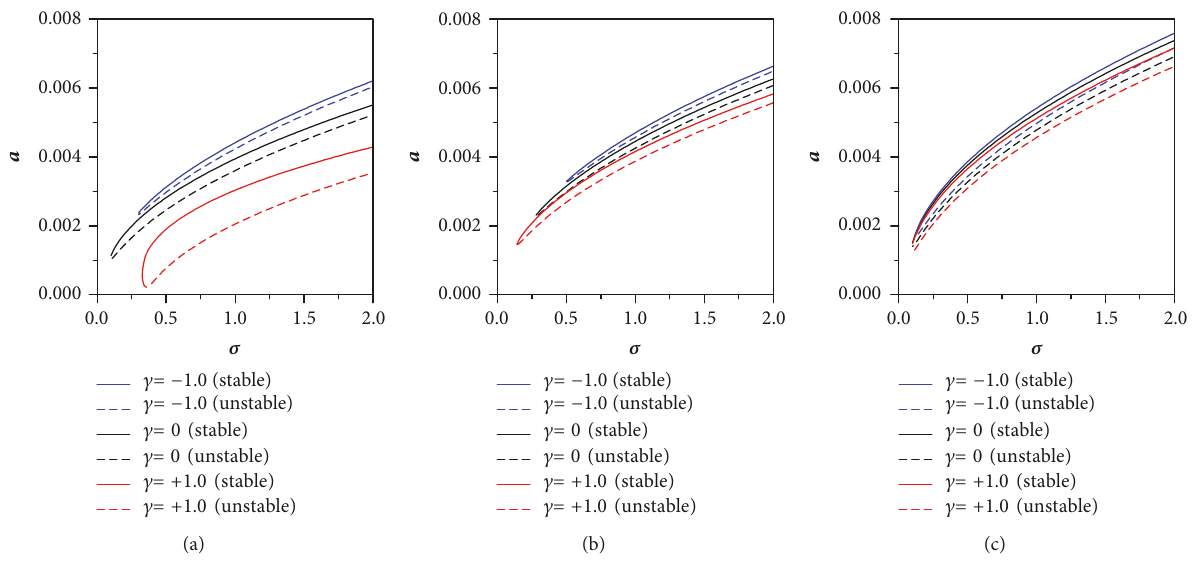
Figure 5: Frequency response curves of subharmonic resonances: (a) hinged-hinged; (b) hinged-fixed; (c) fixed-fixed.